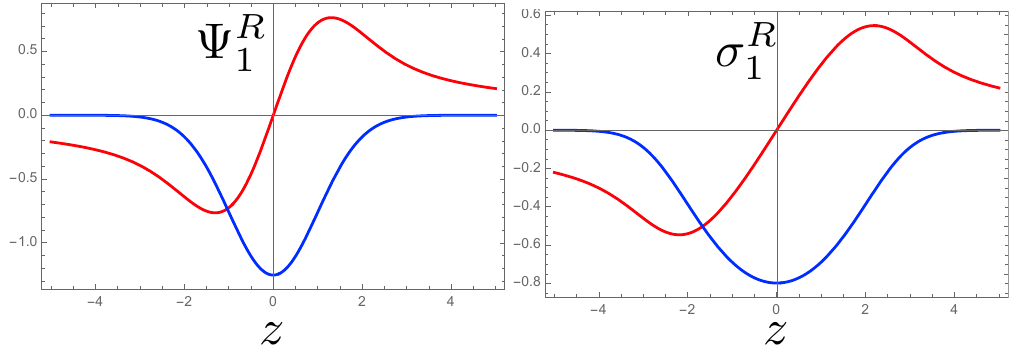
( z )] (blue curve). Right: Re [ σ R 1